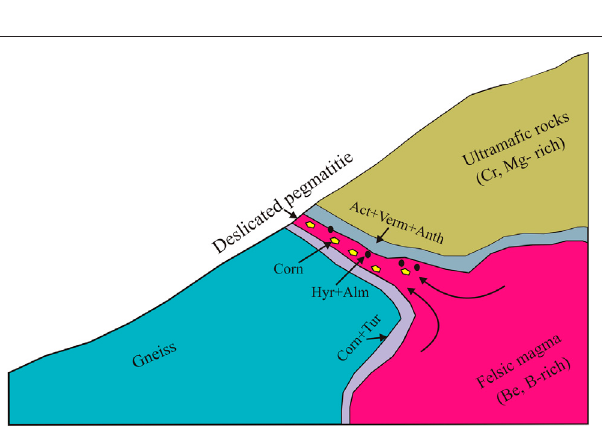
FIGURE 15 | Schematic model showing the metasomatic interaction between felsic magma (pegmatite) and ultrama fi c rocks, from one hand, and gneisswith the other hand. The emplacement ofpegmatite (silica and alumina rich) within ultrama fi c rocks (serpentinites/silica de fi cient rocks), the mineralized zone has been formed with new mineral associations in serpentinites. The newly formed minerals include actinolite (Act), anthophyllite (Anth), and vermiculite (Verm). The residual melt becomes more Al-rich due to silica diffusion. Therefore, alumina-rich minerals have been formed such as corundum(Corn),hercynite(Hyr),andalmandine(Alm).Ontheotherhand,the tourmaline-rich zone was formed at pegmatite and gneiss (containing B-rich fl uids) contact.